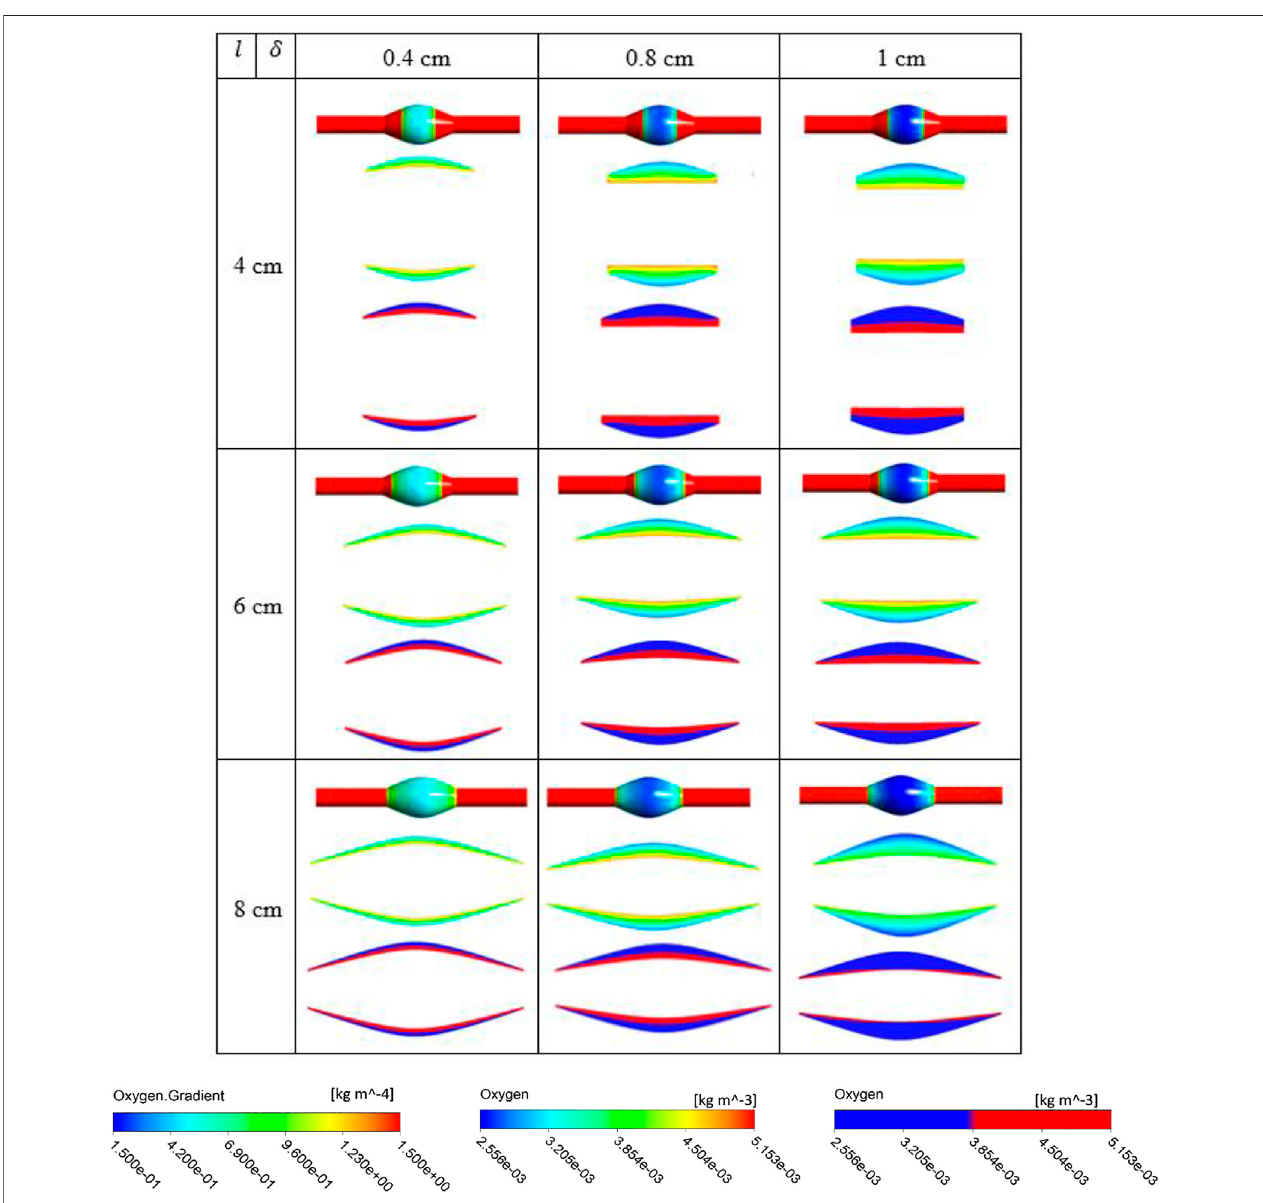
FIGURE 8 | Results of different combination of design variables ILT length ( l ) and ILT thickness ( δ ), with bulge diameter being fi xed as BD = 5 cm. Each cell corresponds to the results for one case of the nine different AAA geometries provided in Figure 2 . In each cell, three oxygen measures are plotted from top to bottom: contourofoxygen fl uxontheabluminalsurfaceofthearterialwallforallanalyzedcasesonthesamescale,contourplotofoxygenconcentrationinILTonthesamescale, and fi nally oxygen value using a two-bands color scale ranging from abluminal oxygen concentration 2.56 × 10 − 3 kg/m 3 (blue) to ≥ 75% C in f kg/m 3 (red). Scales on the bottom are used for displaying